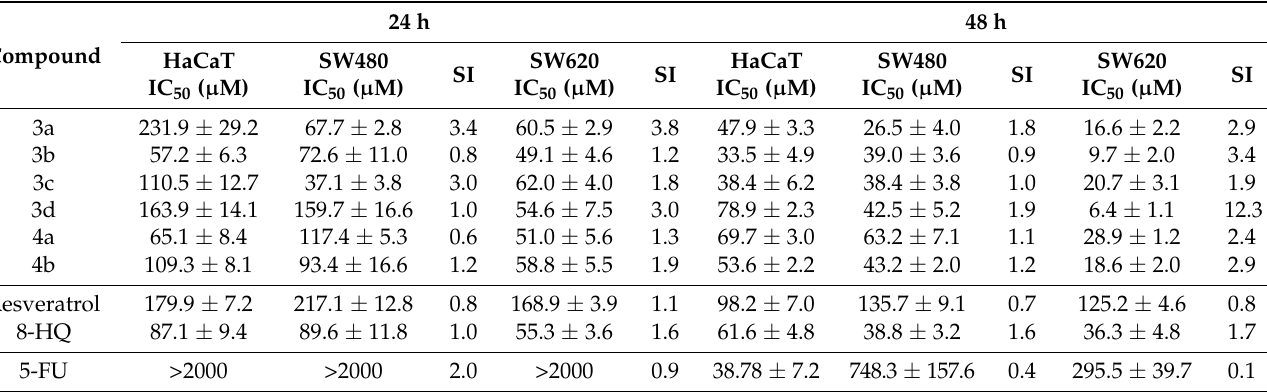
Table 1. Cytotoxic effect (IC50) of styrylquinolines on SW480, SW620 and HaCaT cell lines at 24 and 48 h